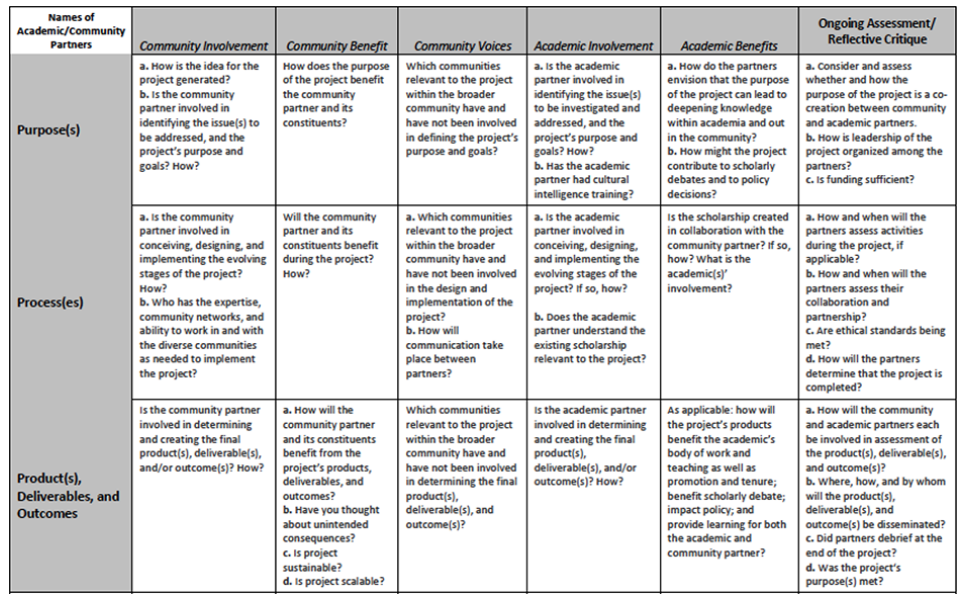
Figure 2 Matrix for planning and implementing a CES